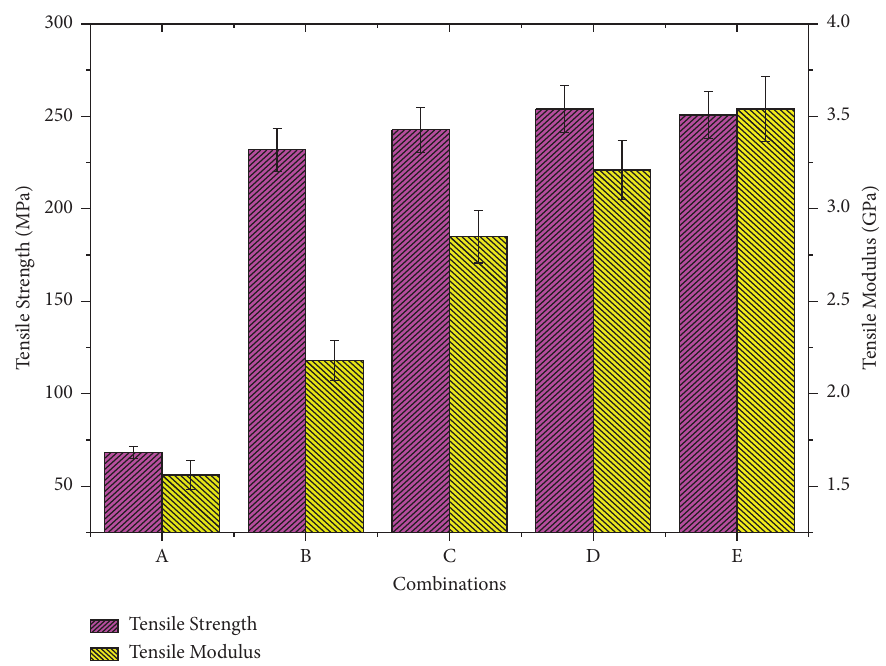
Figure 3: Tensile strength and its modulus of FeO/Kevlar/epoxy based hybrid